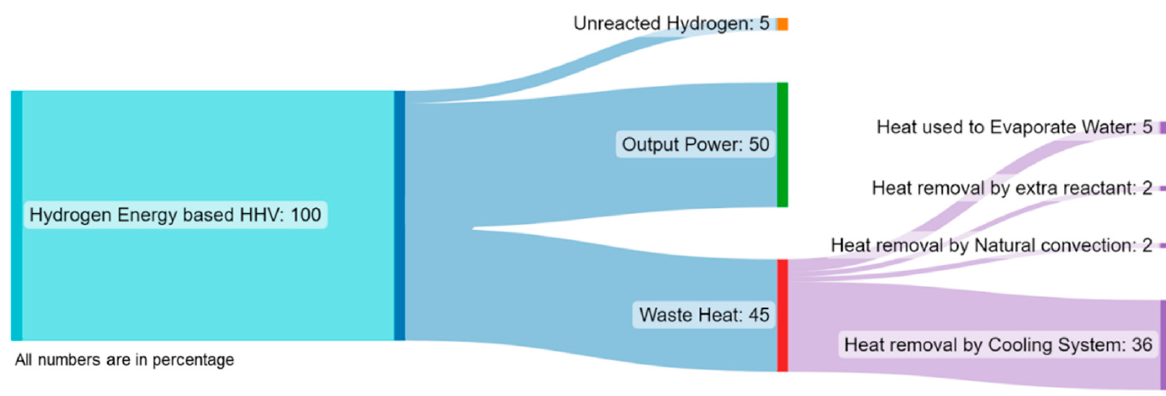
Figure 6. A typical energy flow diagram in a PEMFC (Modified from [76]).